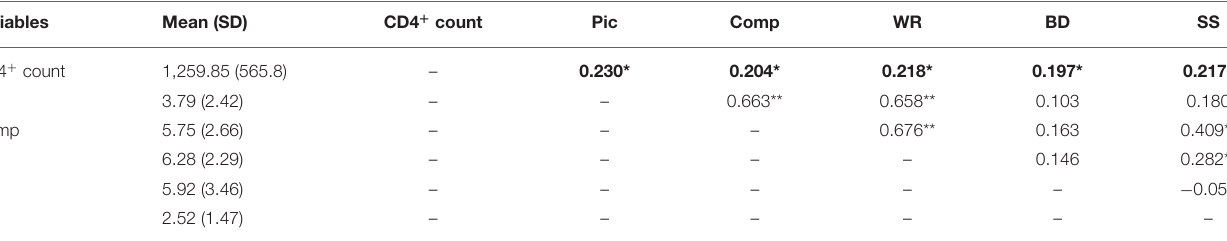
TABLE 3 | Correlations among CD4 + lymphocyte levels cells/mm 3 and subdomains of cognitive function in the study of HIV-positive